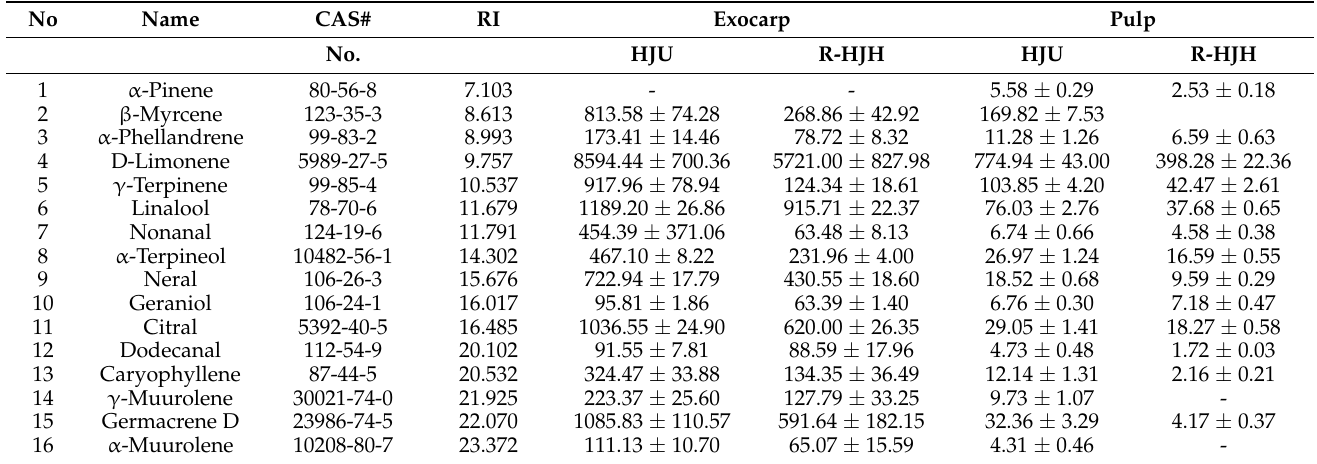
Table 3. Main volatiles compounds ( µ g/mg) in two different fruits tissues of R-HJH and